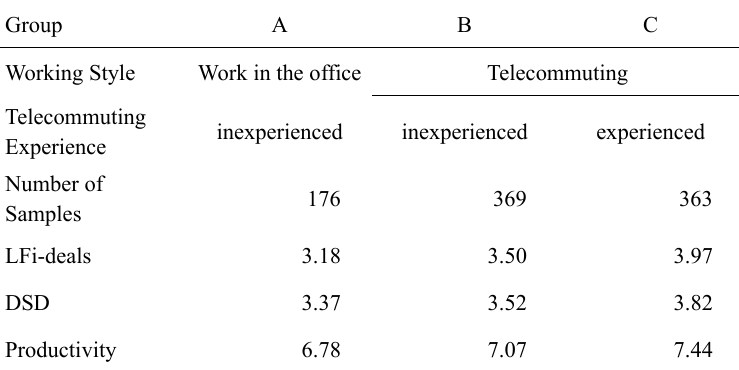
Table 2. Number of samples and mean of each group Group A B